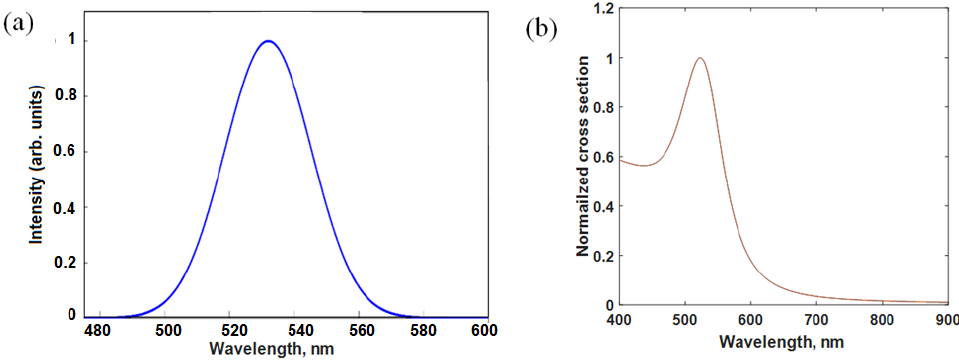
Figure 1. ( a ) Fluorescence emission intensity of ceria nanoparticles with no added gold; and ( b ) absorbption spectrum of gold nanoparticles showing the plasmonic resonance wavelength around 520 nm.